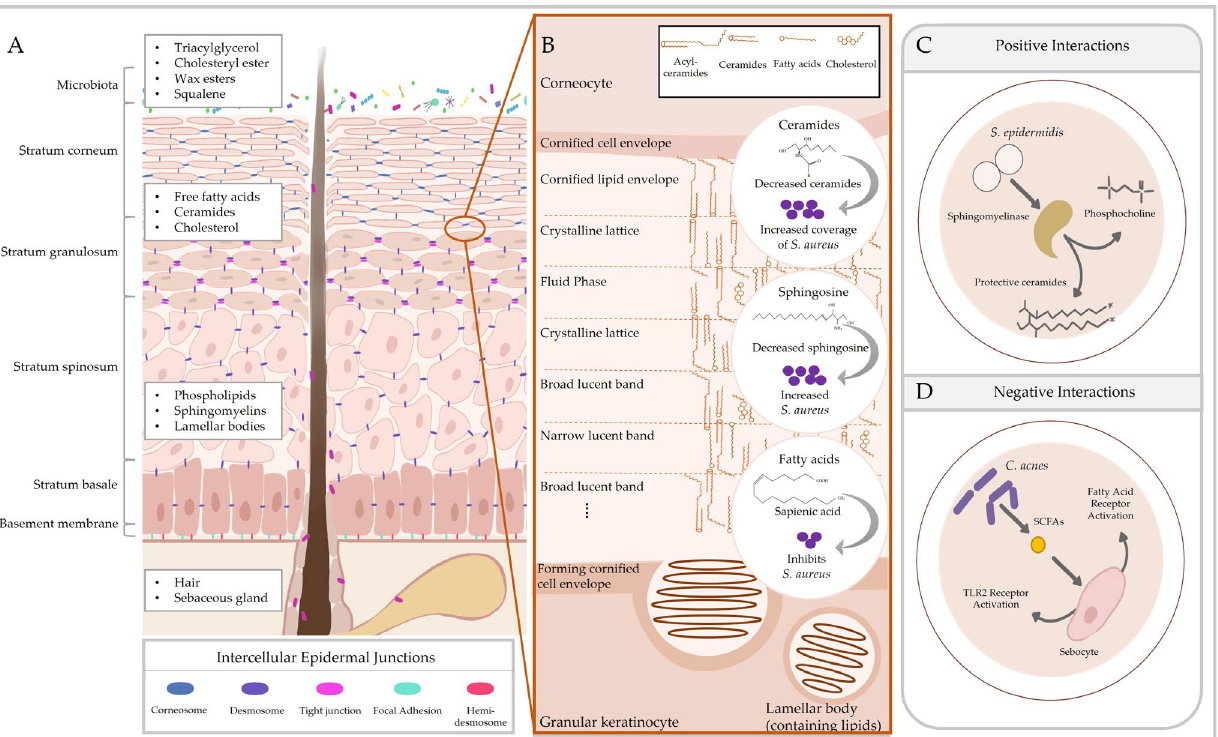
Figure 1. Cutaneous lipids preserve the epidermal permeability barrier and influence host–microbe interactions. The epidermis consists of multiple layers of phenotypically distinct keratinocytes that contribute to stratification. ( A ) Keratinocytes in each tier exhibit different adhesion structures responsible for maintaining skin integrity. Epidermal lipids are observed in the differentiating layers of the epidermis, while sebaceous lipids are secreted from sebaceous glands. ( B ) Molecular arrangement of the main stratum corneum lipids from [51] and effects of those lipids on Staphylococcus aureus colonisation [52–54]. ( C ) Skin microbiota also produce metabolites to utilise cutaneous lipids, generating products that contribute to barrier homeostasis (e.g., sphingomyelinase in Staphylococcus epidermidis [55]). ( D ) In pathological conditions, these interactions may negatively affect skin physiology (e.g., Cutibacterium acnes enhancing inflammation [56]). SCFA = short-chain fatty acids.